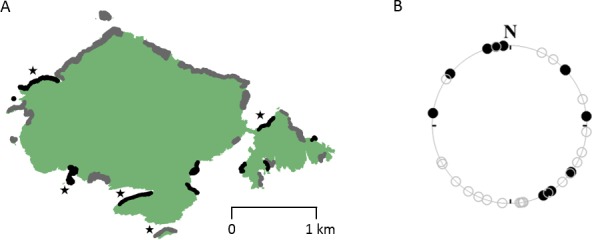
The distribution and orientation of guillemot breeding colonies on Skomer Island (digitised from the 2015 breeding bird survey [Stubbings et al., 2015]).(A) Breeding colonies (grey and black regions) appear to be distributed all around Skomer, however, bearings of the 11 densest colonies (marked in black), given in (B), show that while colonies appear uniformly distributed overall (Z = 0.314, p=0.346, df = 10, Rayleigh test), none are oriented towards the prevailing south-westerly wind direction, despite the availability of cliff habitat (unoccupied sections are indicated with open circles). Study colonies are indicated with stars.